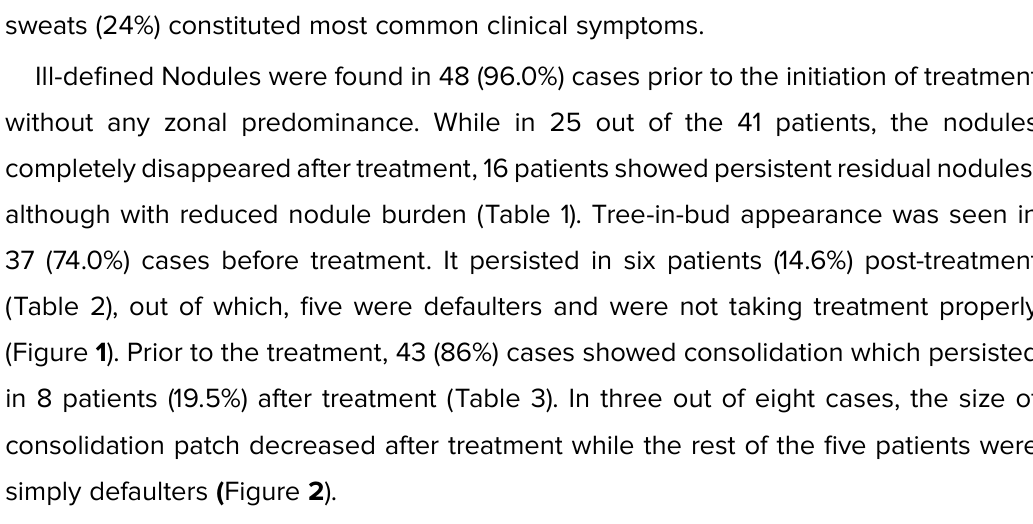
TABLE 1: Frequency distribution of ill-defined nodules in pre- and posttreatment cases. Ill-defined Nodule Pretreatment Posttreatment